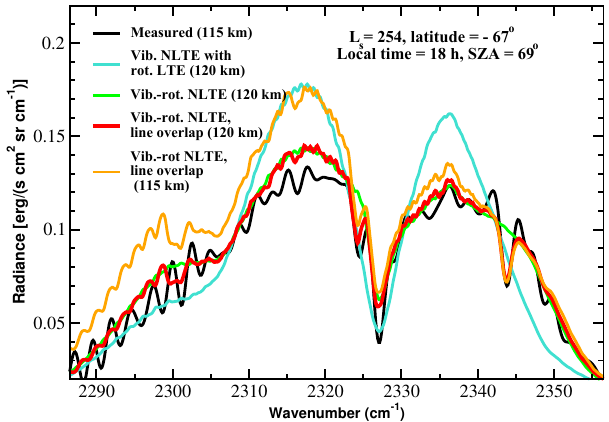
Figure 1. Comparison of measured (black) and simulated PFS SWC spectra. The observed spectrum is an average of 27 single scans taken for the following conditions: L s = 254, latitude =− 67 ◦ , lo- cal time = 18:00, SZA = 69 ◦ , and tangent height of 115km. The 1 σ random uncertainties for this measured spectrum are shown. The simulated spectra are shown for tangent height of 120km includ- ing only vibrational non-LTE in CO 2 (turquoise), with vibrational– rotational non-LTE (green), and with vibrational–rotational non- LTE plus line overlapping along the line of sight (red). The spectra shown in orange color are calculated with the same assumptions as for red, but for tangent height 115km as a demonstration (see text for detailed